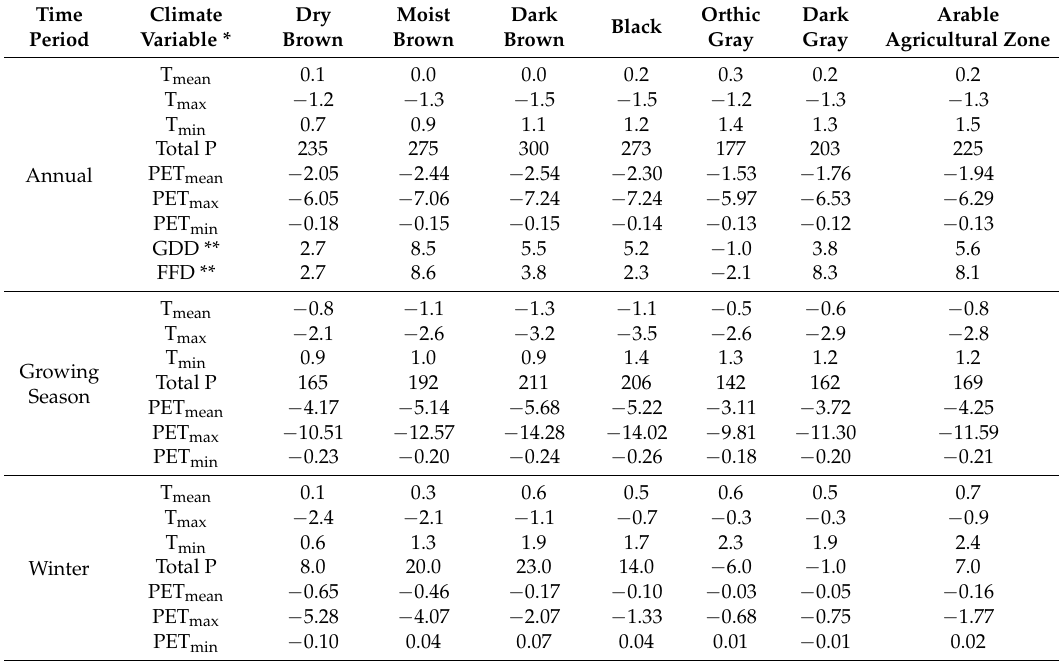
Table 4. Summary of climatic change from trends by soil zone and Saskatchewan’s arable agricultural zone